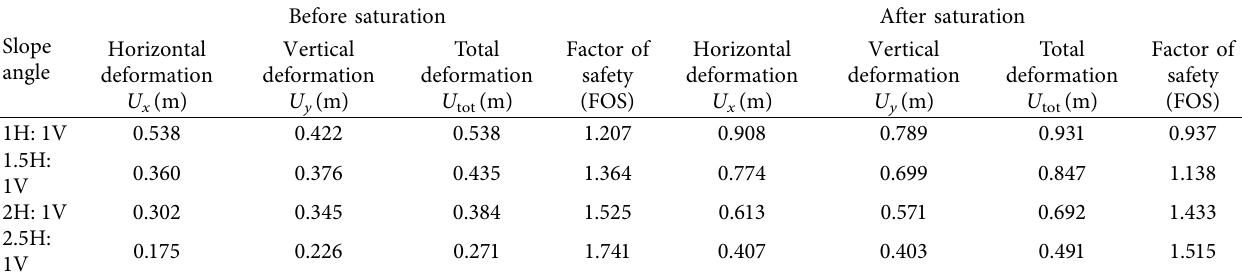
Vertical Total Factor of deformation deformation safety (FOS)